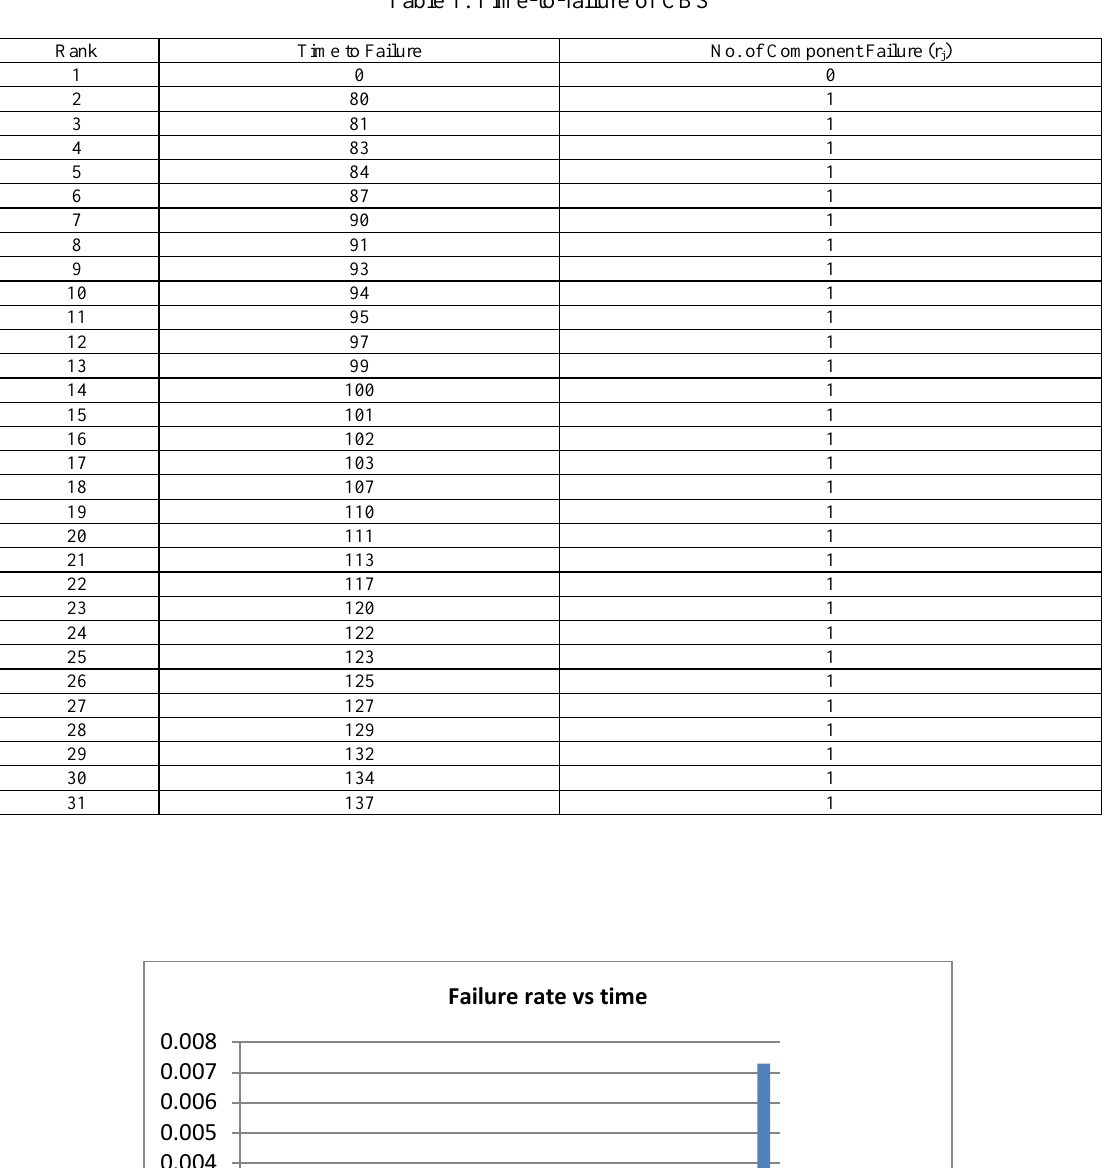
Table 1. Time-to-failure of CBS